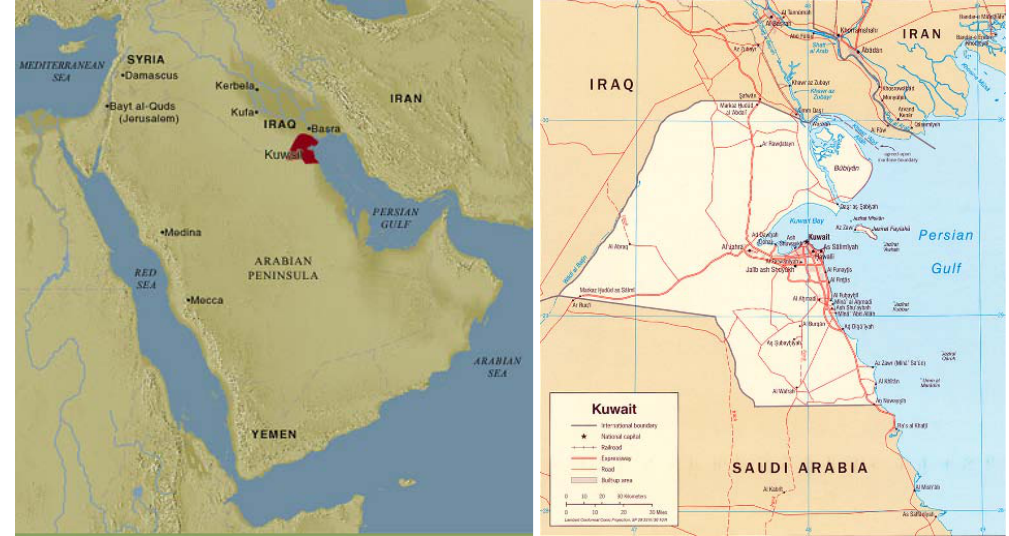
Fig. 1. Kuwait’s geographical location within the Arabian Peninsula (red area, left panel), and an enlarged map of Kuwait (right panel).